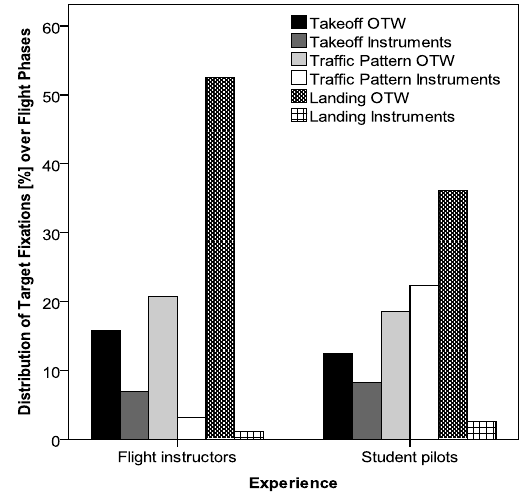
Figure 10. Relative Amount of Target Fixations for Pinnacle.